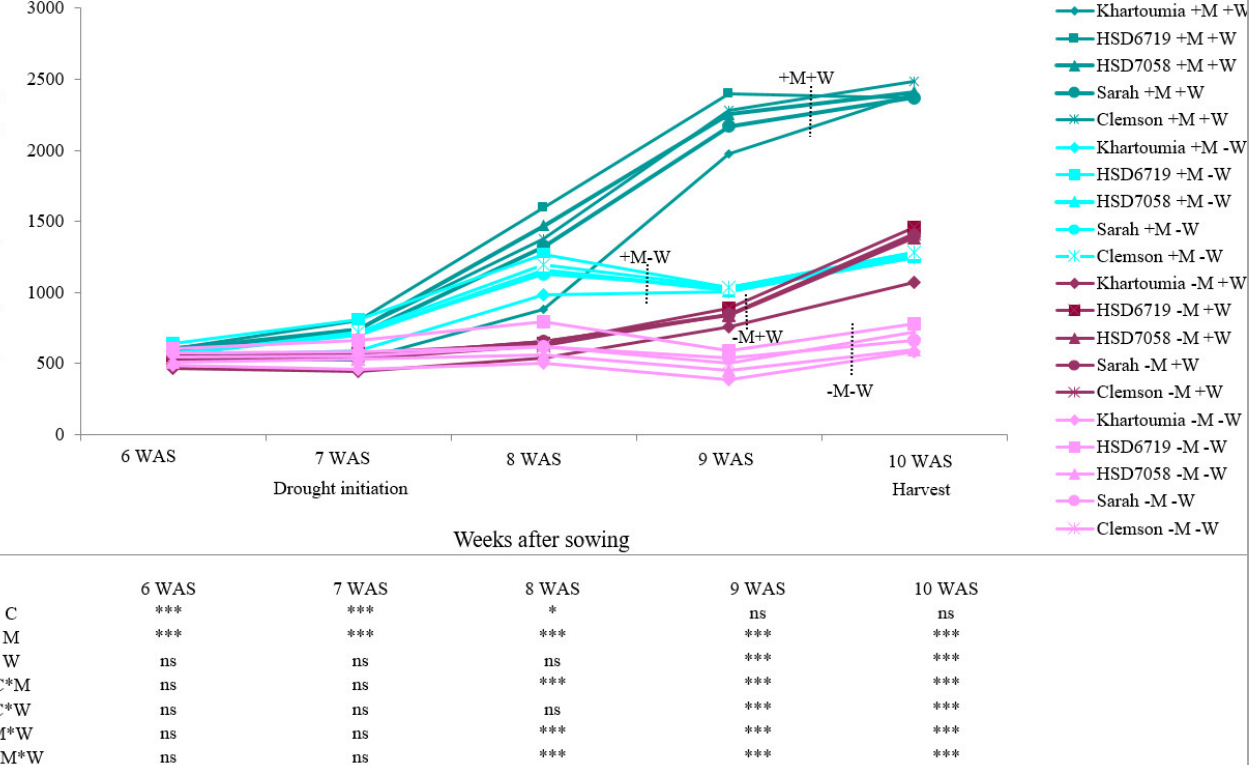
Figure 3. Weekly evapotranspiration (mL per plant). Plants were non-inoculated (−M) or inoculated (+M) with R. irregulare . Substrate water content was either maintained at 20% (+W) or reduced 10% w/w (−W). Asterisks indicate significant differences in cultivar (C), AM inoculation (M) and substrate water content (W) and their interactions (Kruskal-Wallis test, n = 4, p < 0.05 (*), p < 0.01 (**), p < 0.001 (***) and p > 0.05 (ns)). Results are shown as mean value ± standard